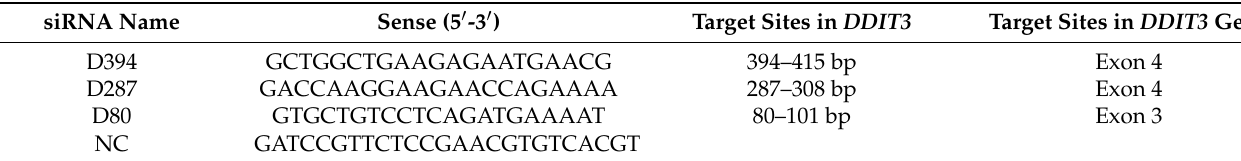
Table 2. Sequences and positions of 3 siRNAs against DDIT3 gene.